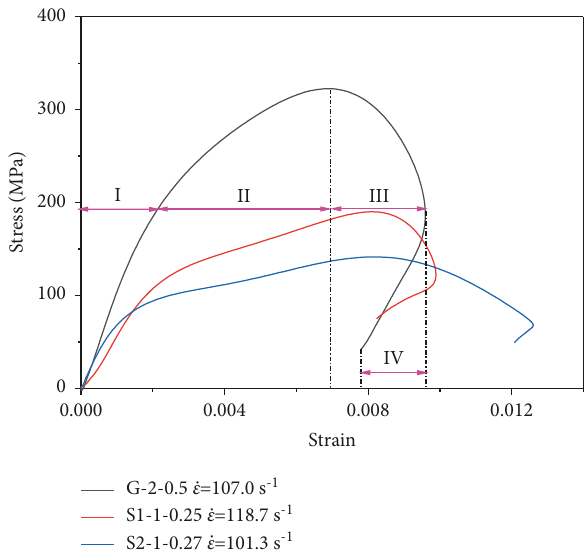
Figure 6: Typical dynamic stress-strain curves of granite, cyan sandstone, and red sandstone